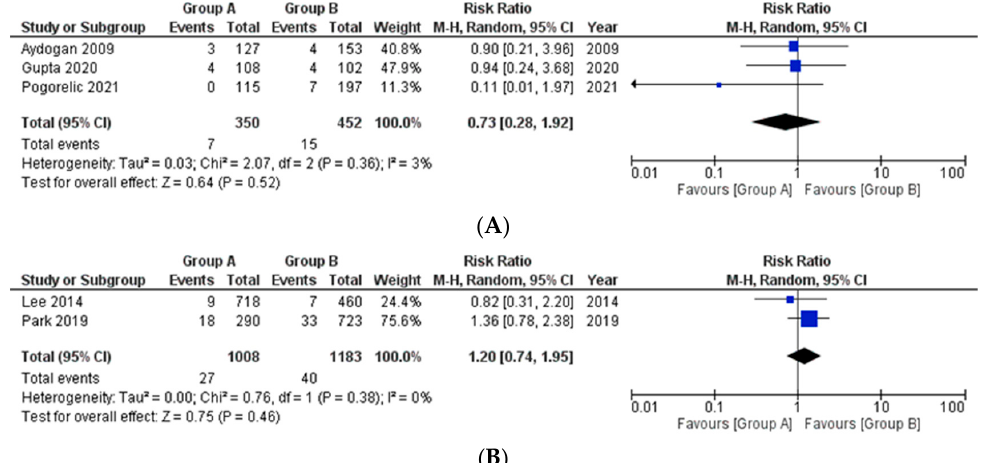
was used) in terms of the incidence of SSI/Intra-abdominal collections. Figure 2A, B depict the out- come comparison with respect to appendicular base ligation and mesoappendix division,